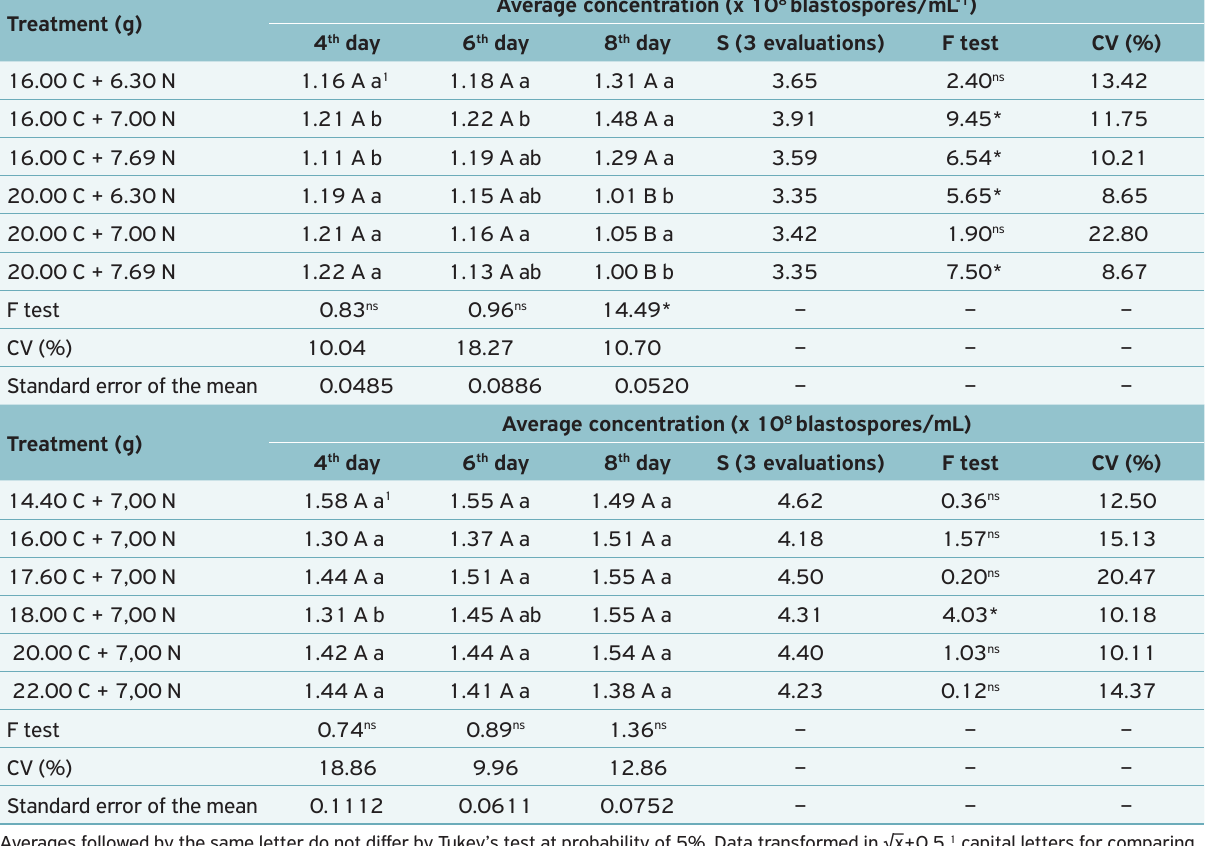
Table 2. Average concentration of Metarhizium anisopliae (IBCB 425), obtained from liquid culture medium with different concentrations of nitrogen and carbon at four, six and eight days after inoculation (at 26 ± 1°C and 12-hour